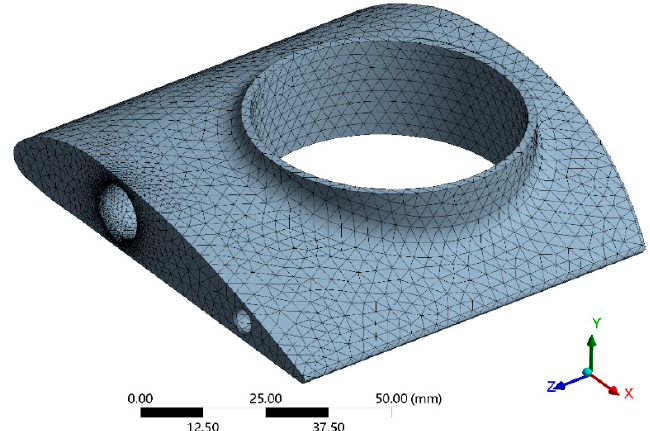
Figure 4. Mesh of the model.